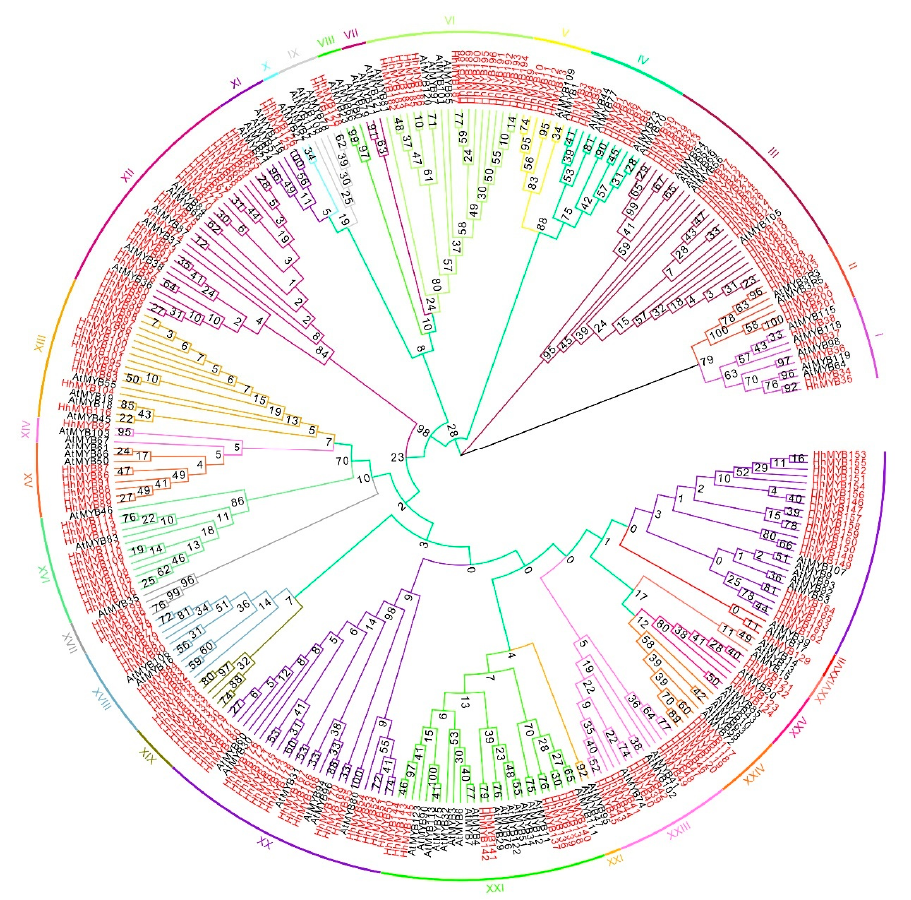
Figure 1. Phylogenetic tree of MYB family members of H. hamabo and A. thaliana using the NJ method. The prefix At was used before the names of the Arabidopsis MYBs. The subfamilies were represented by different colors.